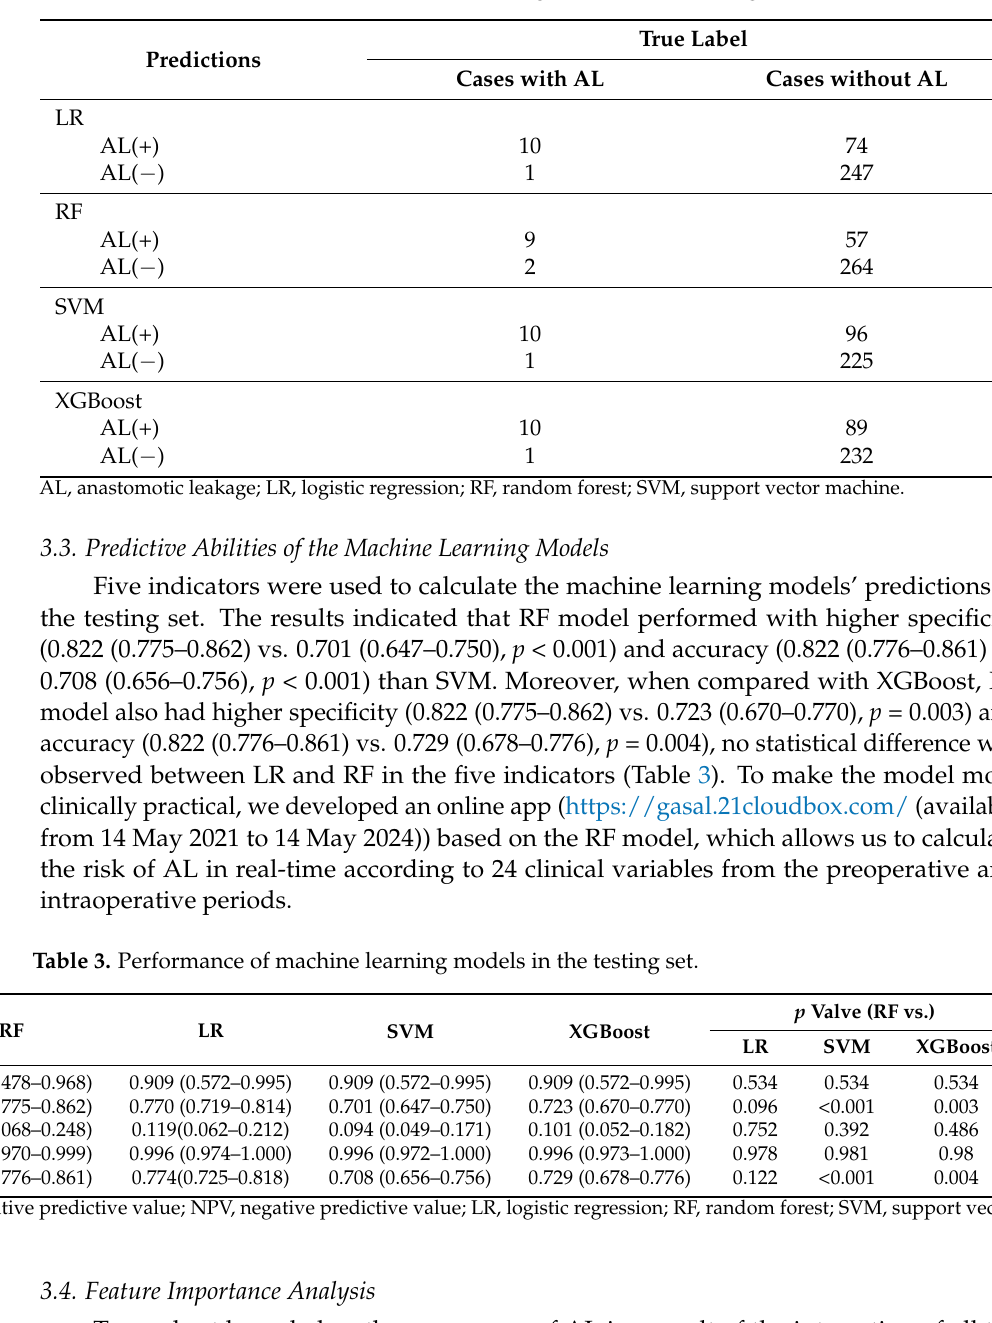
Table 2. Predictive results of four machine learning models in the testing set.